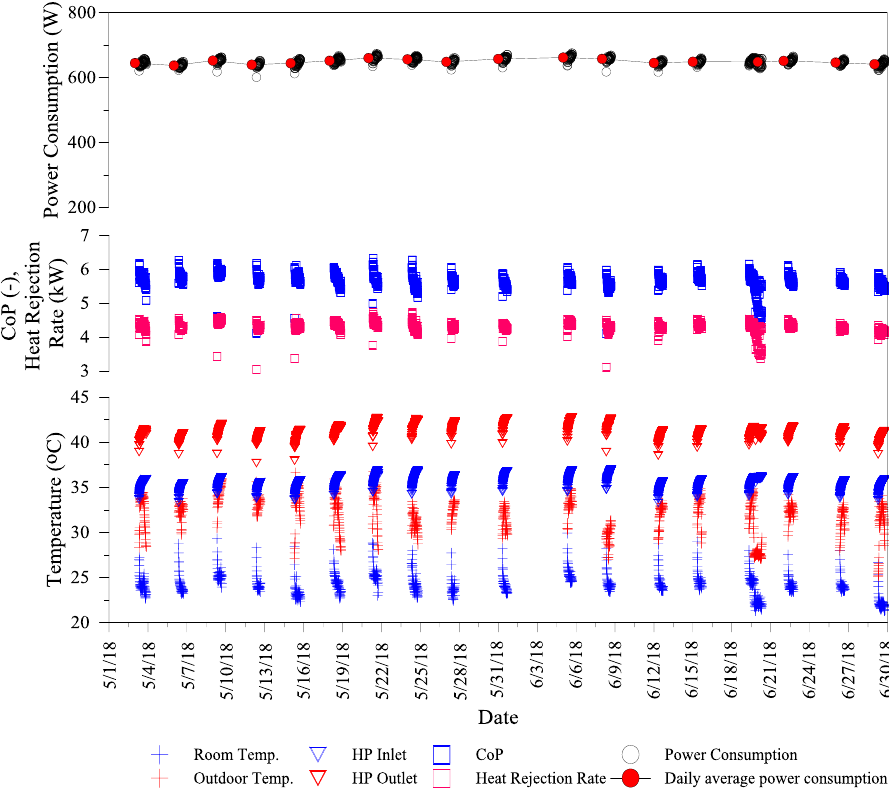
Figure 11. Performance of GSHP 1 (10-min interval data during the operational period).